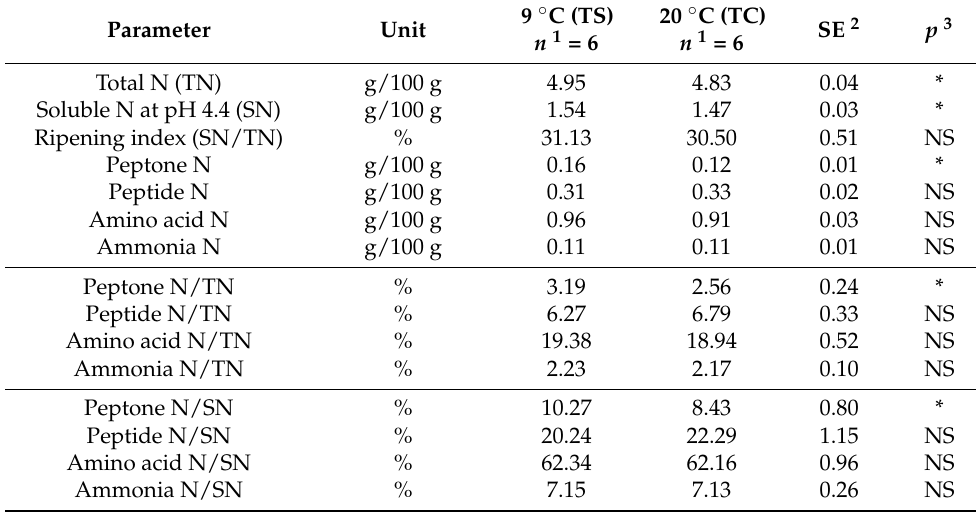
Table 5. Proteolysis and organic acid composition in the inner zone of cheese wheels produced by milk kept at the farm at 9 ◦ C (MC9) or 20 ◦ C (MC20) (least-square-mean values). Parameter